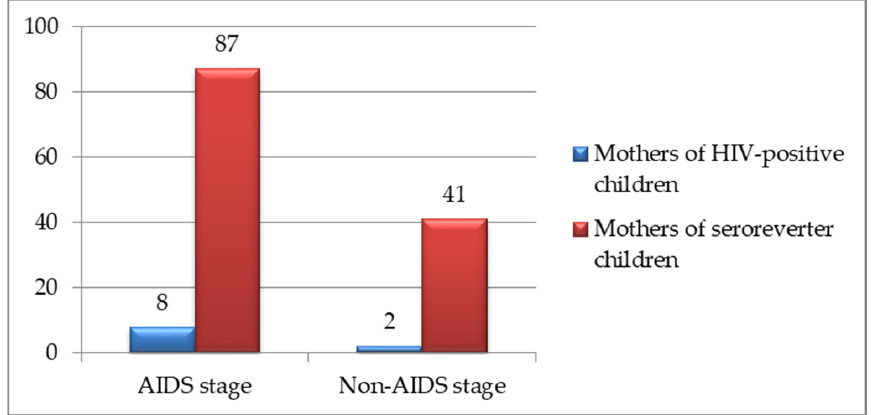
Figure 3. Clinical and immunological classification for HIV infection during pregnancy.